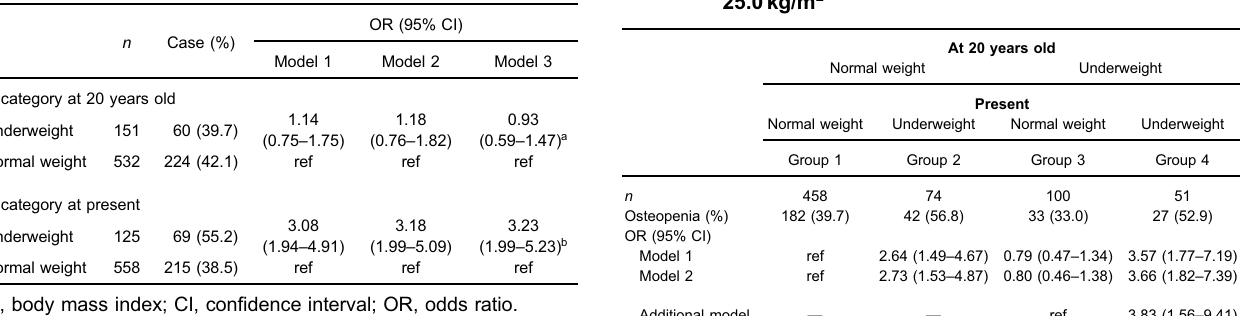
Table 3. Multivariate-adjusted odds ratios of underweight for osteopenia according to BMI at 20 years old and at present among women with BMI less than 25.0kg/m 2